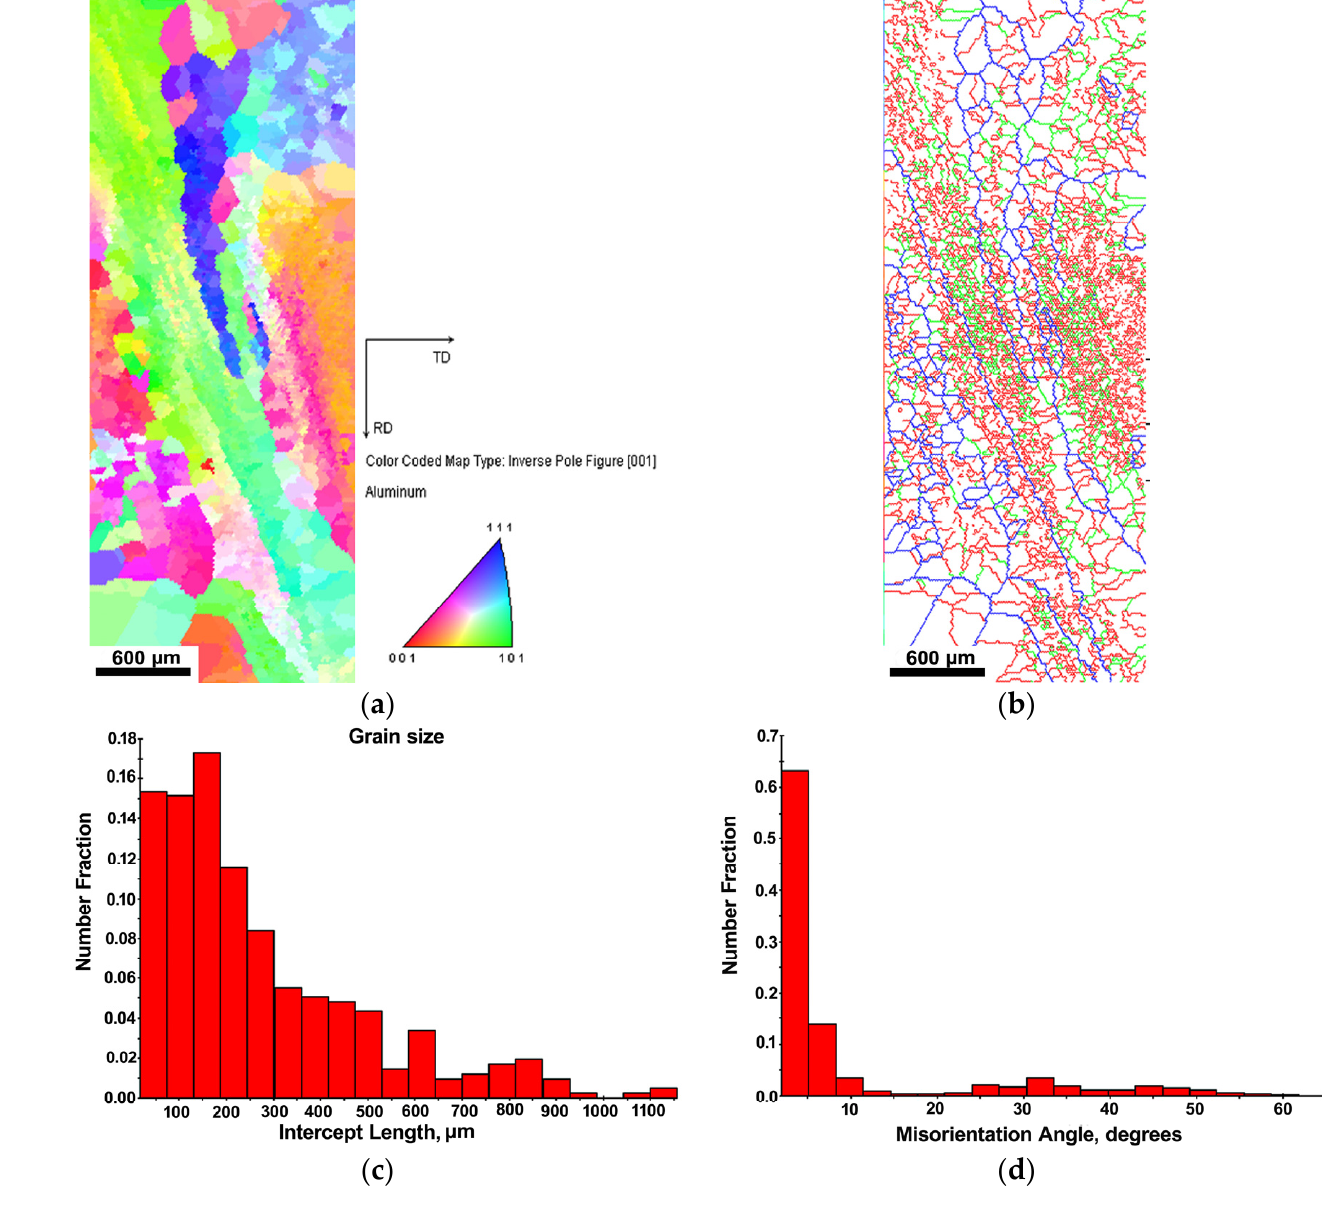
Figure 7. EBSD analysis of AlMnGr composite: orientation map ( а ); grain boundary map (HABs > 15° are in blue, LABs > 5° are in green, and LABs < 5° are in red) ( b ); histogram of grain–subgrain size distributions ( c );misorientation angles ( d ).